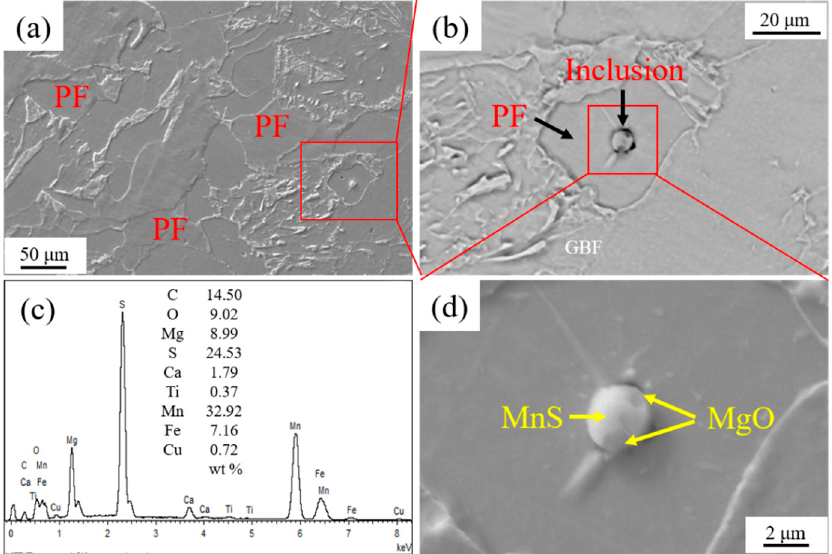
Figure 6. Inclusion related to microstructure in HAZ of experimental steel HM. ( a ) HAZ microstructure, ( b ) inclusion, ( c ) energy dispersive spectrometer (EDS) analysis result of inclusion, and ( d ) component of inclusion.